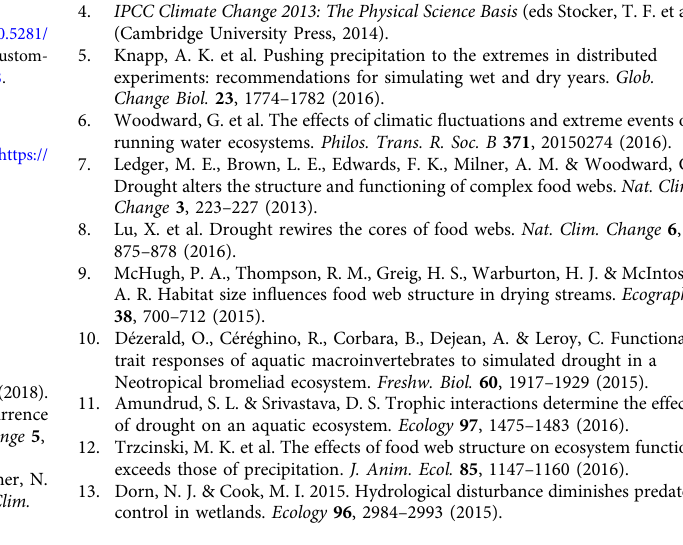
Fig. 4 Relationships between pyramid shape and biomass. Relationships between total predator to detritivore mass ratio (pyramid shape) and a biomass of the whole community (top predators + mesopredators + detritivores), b biomass of total predators (top predators + mesopredators), and c biomass of detritivores. All values of biomass are log-transformed (logarithm base e ). Circle colors indicate sites of the experiment; colors match with the sites plotted in Fig.